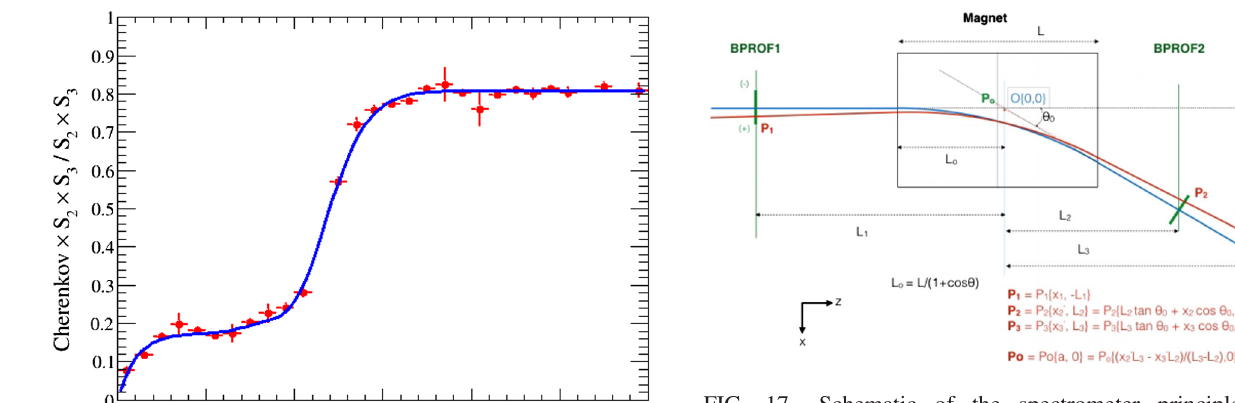
FIG. 17. Schematic of the spectrometer principle, taken from [26].